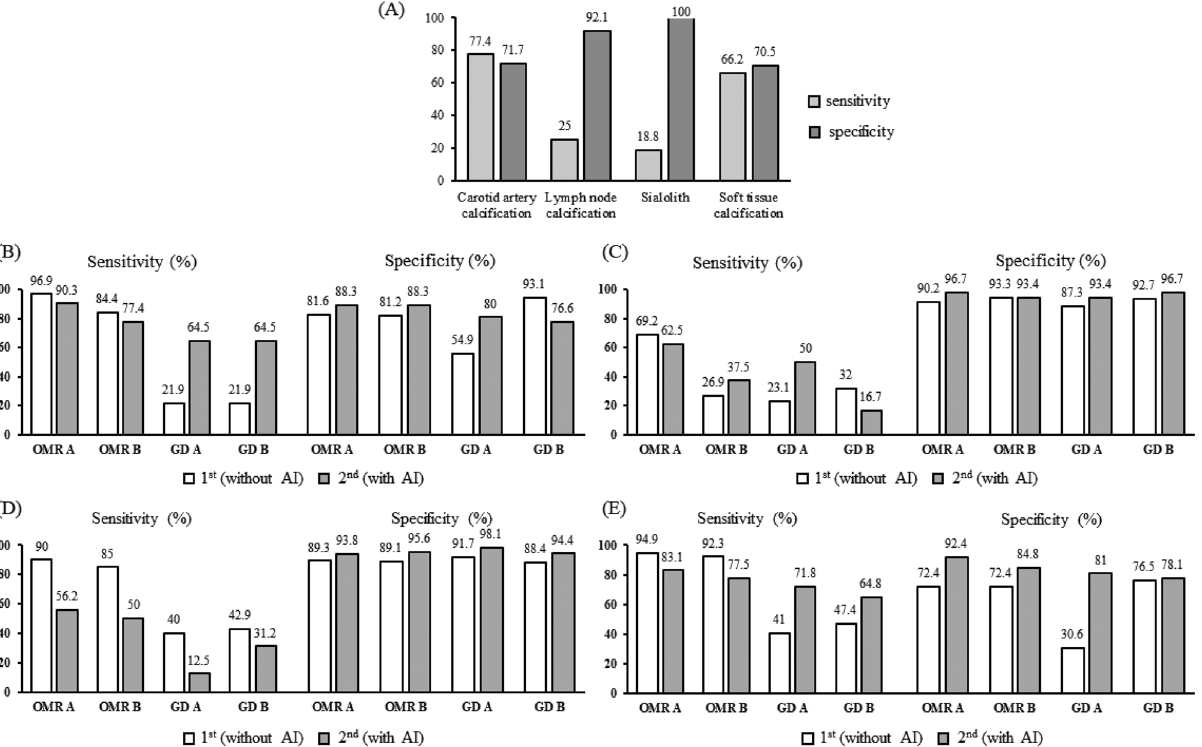
Figure 3. Comparison of AI and observer performances. Sensitivity and specificity of ( A ) artificial intelligence detection for all cases, ( B ) carotid artery calcification, ( C ) lymph node calcification, ( D ) sialolith, and ( E ) all soft tissue calcification with and without artificial